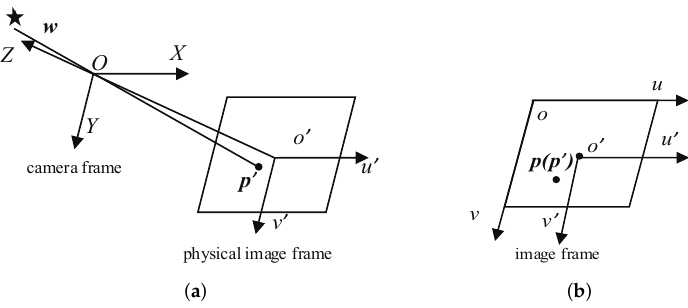
Figure 1. Reference frames. ( a ) Camera frame and physical image frame; and ( b ) physical image frame and image